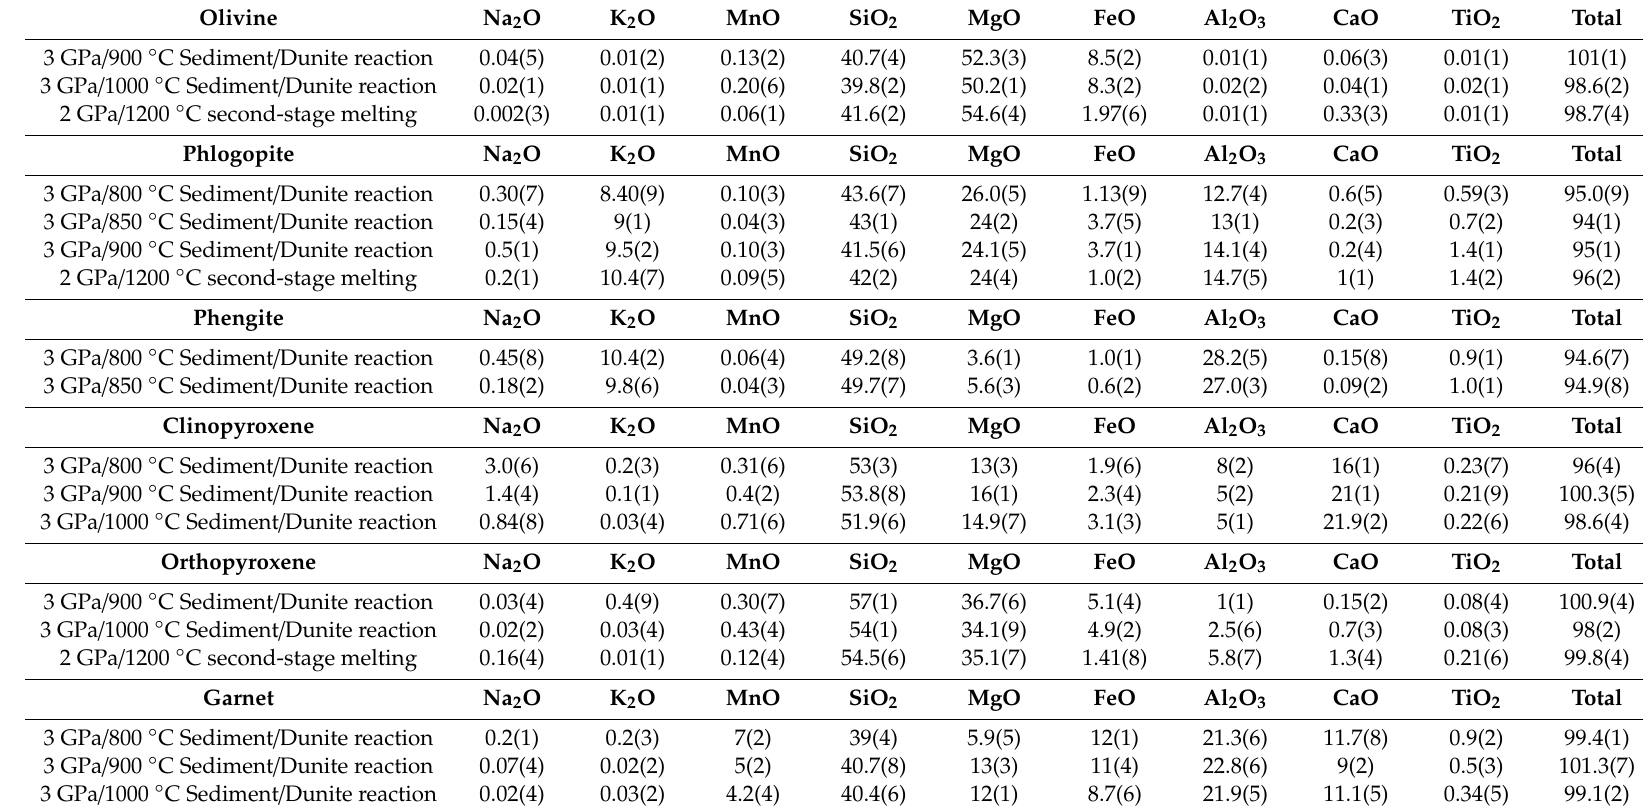
The number in parentheses represents one standard deviation on the last